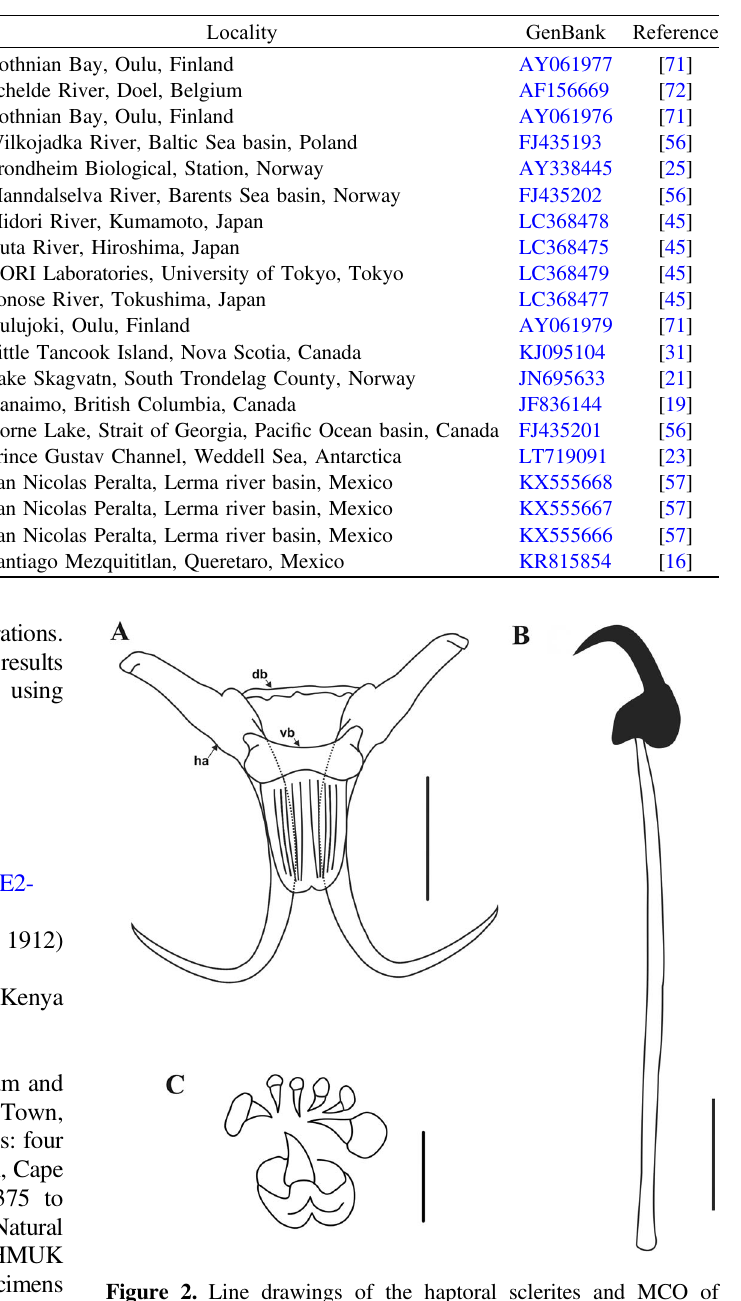
Table 3. List of Gyrodactylus species included in the phylogenetic analyses with their hosts, collection site, GenBank accession number, and reference.